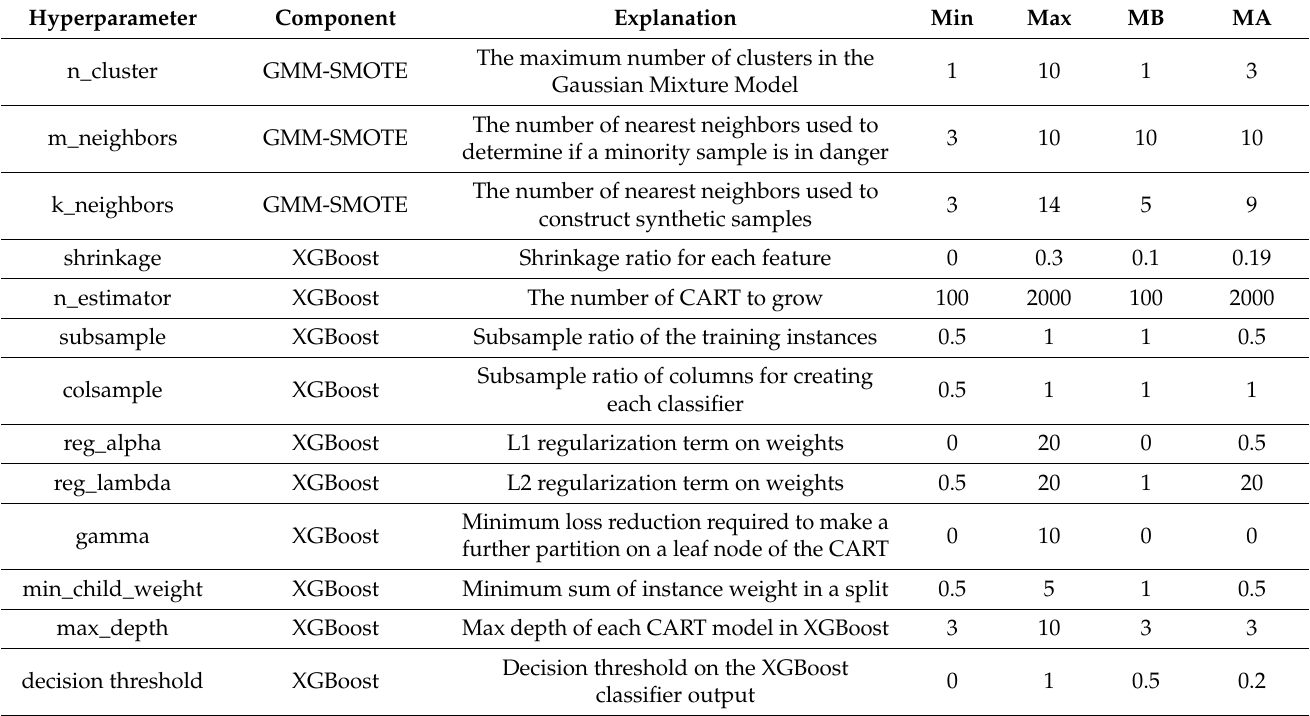
Table 2. Hyperparameters tuned for GMM-SMOTE and XGBoost. The Min and Max define the search ranges for each hyperparameter during the tuning processes. The initial value (before tuning, MB) and the final values (after tuning, MA) are given in the last two